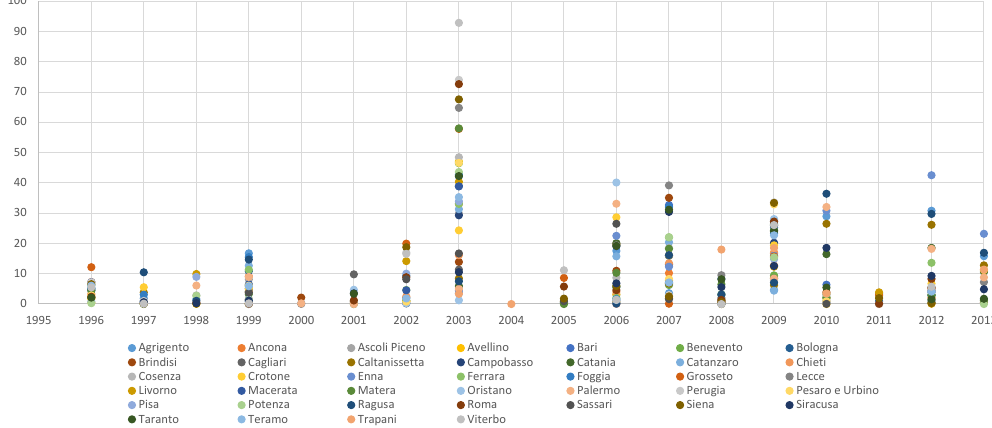
Figure 1. Estimated intensity of the early heat waves affecting the selected 39 Italian provinces in the period 1995–2013. Values are in degrees and colours are associated with the provinces.